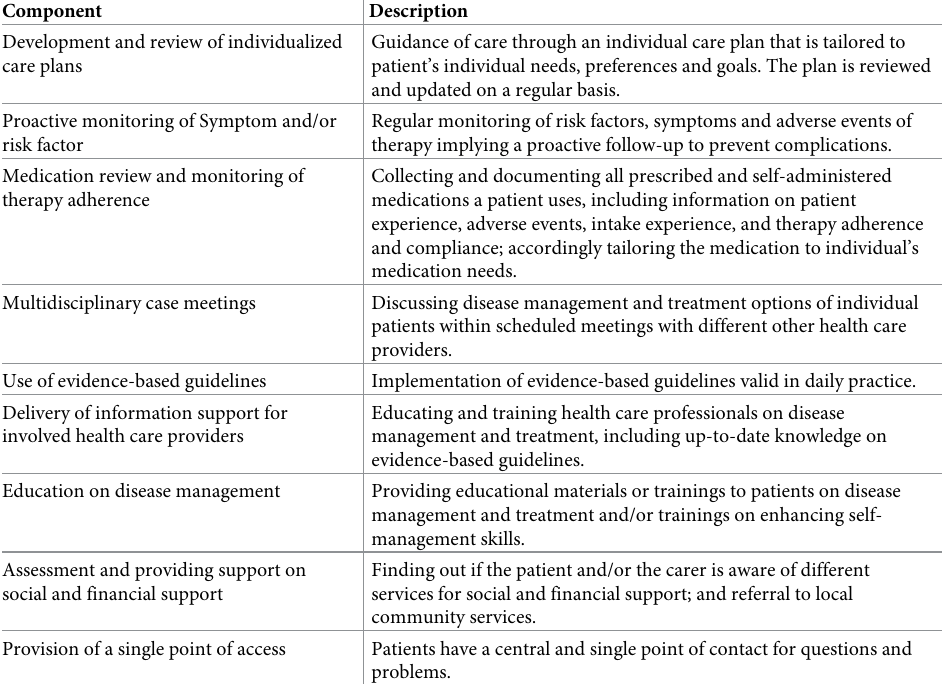
Table 1. Description of predefined core elements of case management interventions derived from previous stud- ies [7, 8]. Component